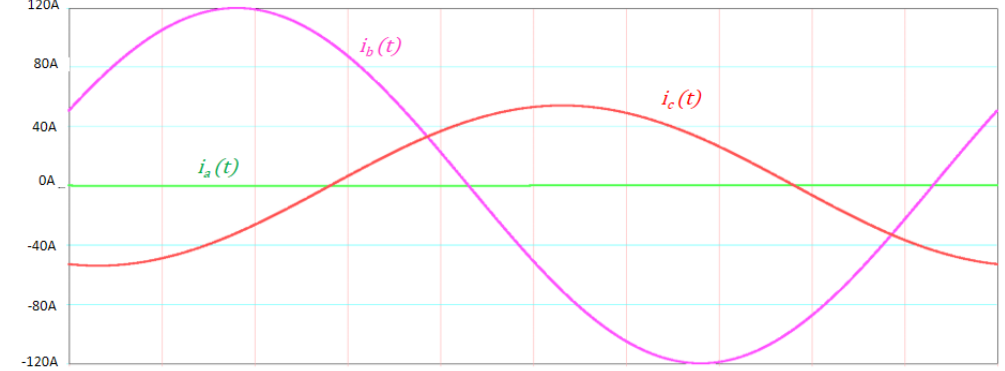
Figure 9. Line currents before compensation in PCC.